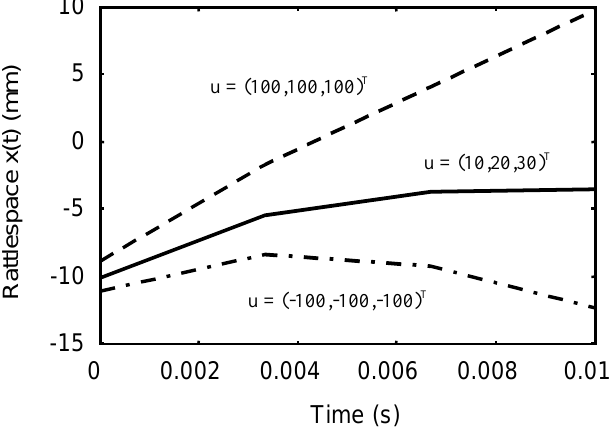
Fig. 3. Influence of u ( t ) on the rattlespace x ( t )